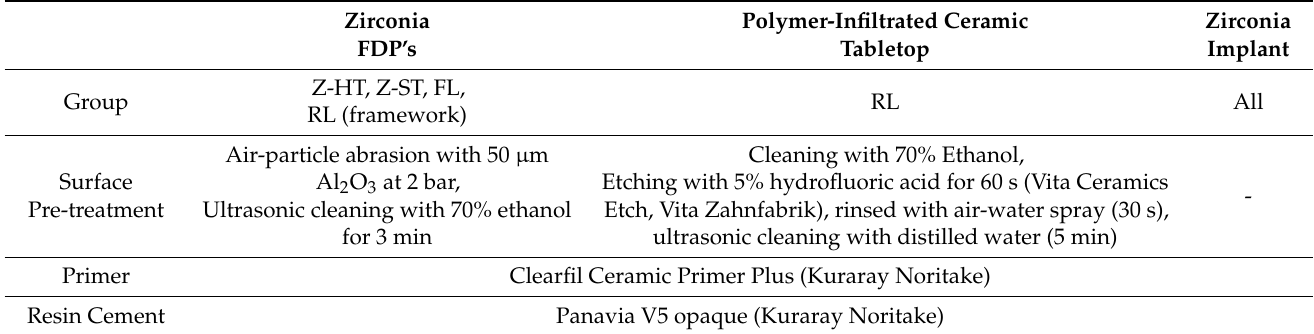
Table 2. Pretreatment and adhesive cementation of tested